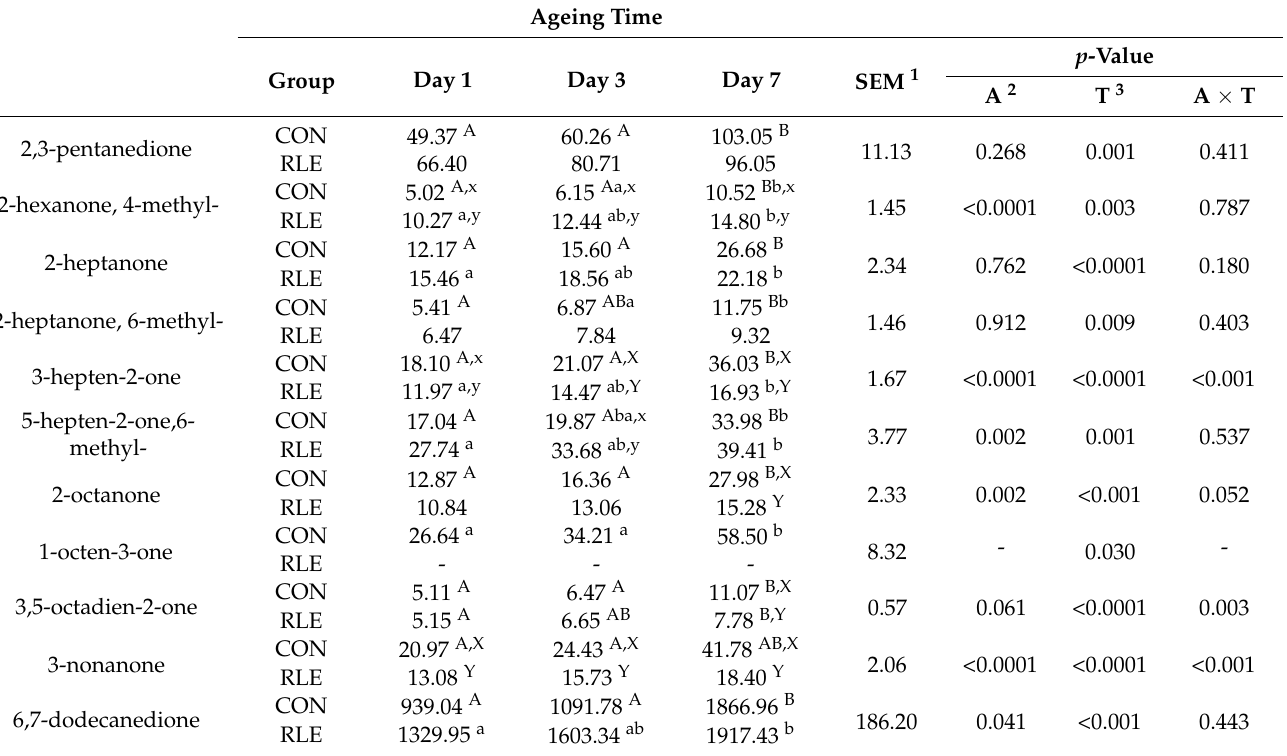
Table 4. Effects of anthocyanin diet addition and ageing on ketone volatile compounds of meat from goat kids ( n = 30 samples for each experimental group). Results are expressed as ng/g of